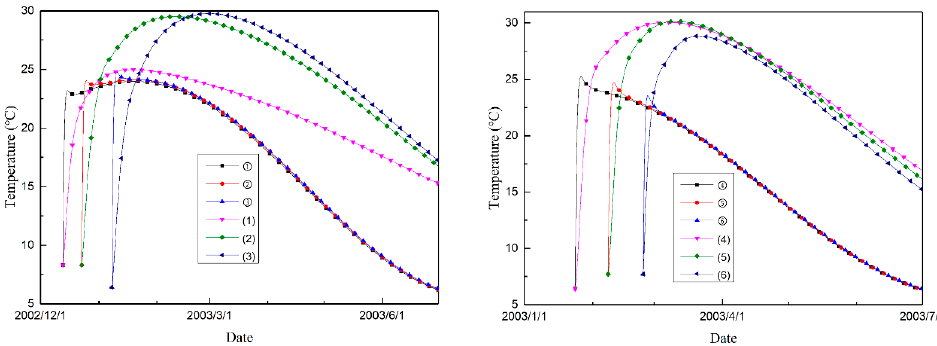
Figure 7. The temperature histories of different typical points.